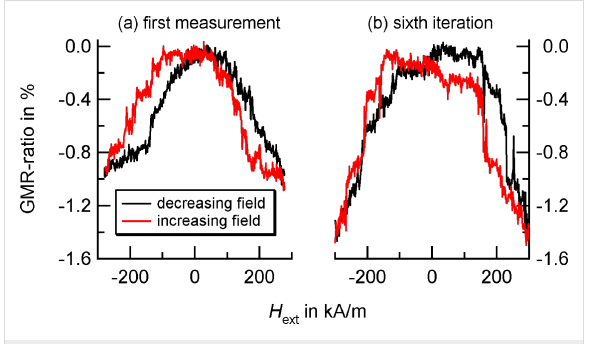
Figure 15: Magnetoresistance measurements at room temperature on a granular system consisting of Co nanoparticles with a mean dia- meter of ‹ D › = (14.9 ± 0.4) nm covered with a 4 nm thick Cu-layer. The measurements have been taken from a series (a) at the very begin- ning and (b) after six